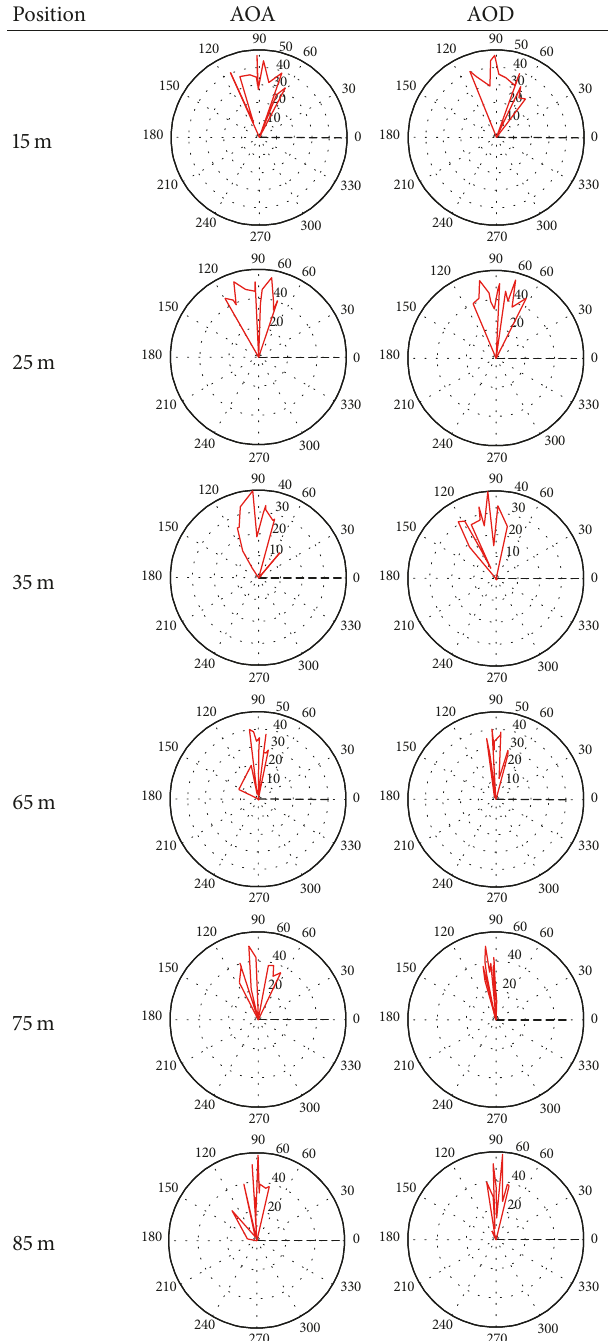
Table 5: AOA and AOD at each position.